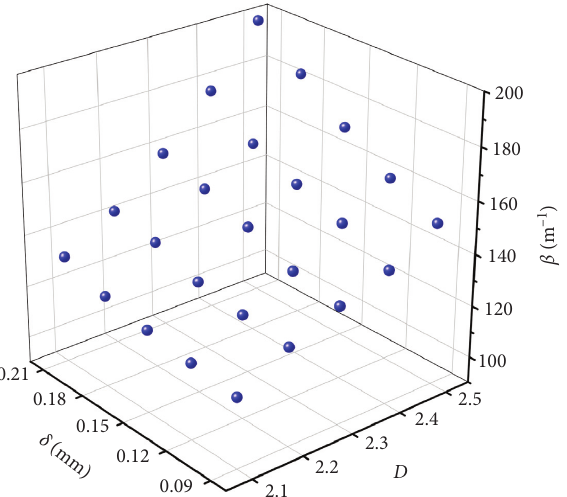
Figure 8: The relationship between the non-Darcy inertia coefficient and geometric characteristics.